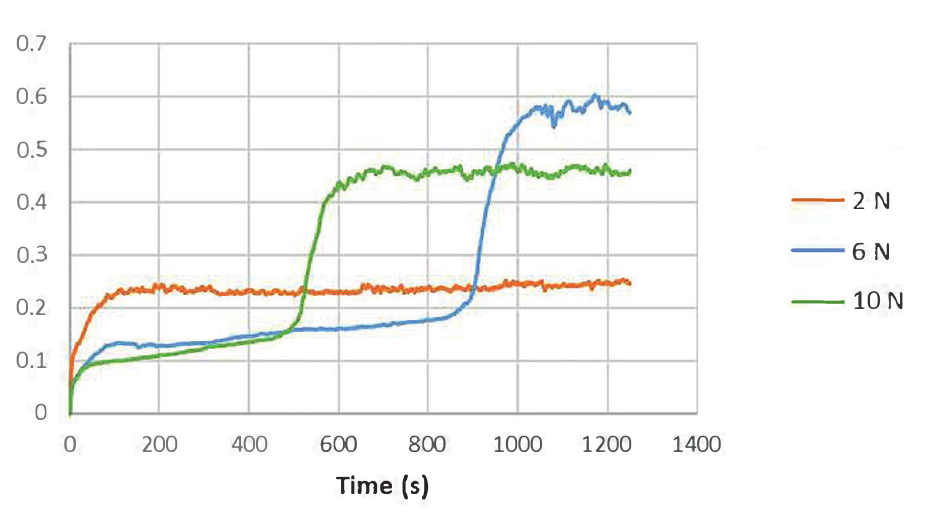
Figure 16. Friction coefficients over time with forces of 2 N, 6 N and 10 N.